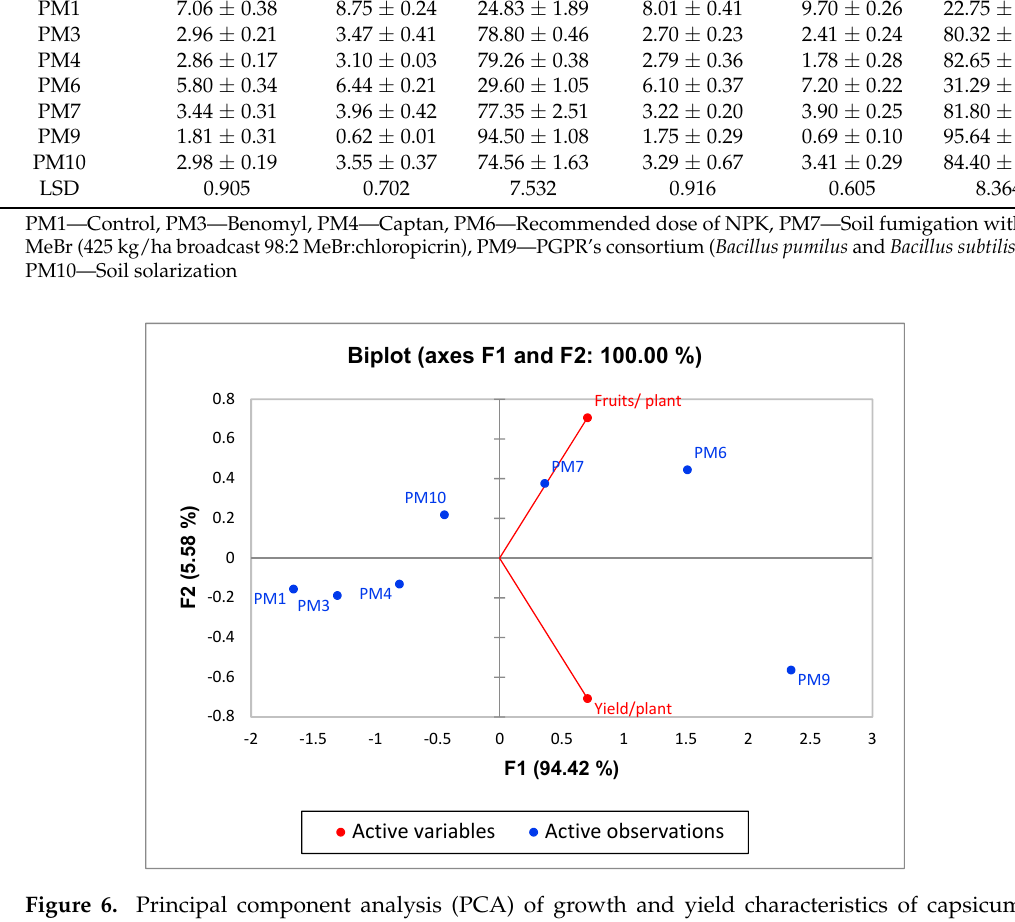
Table 1. Efficacy of PGPR’s consortium to control damping off and anthracnose in capsicum under field conditions.